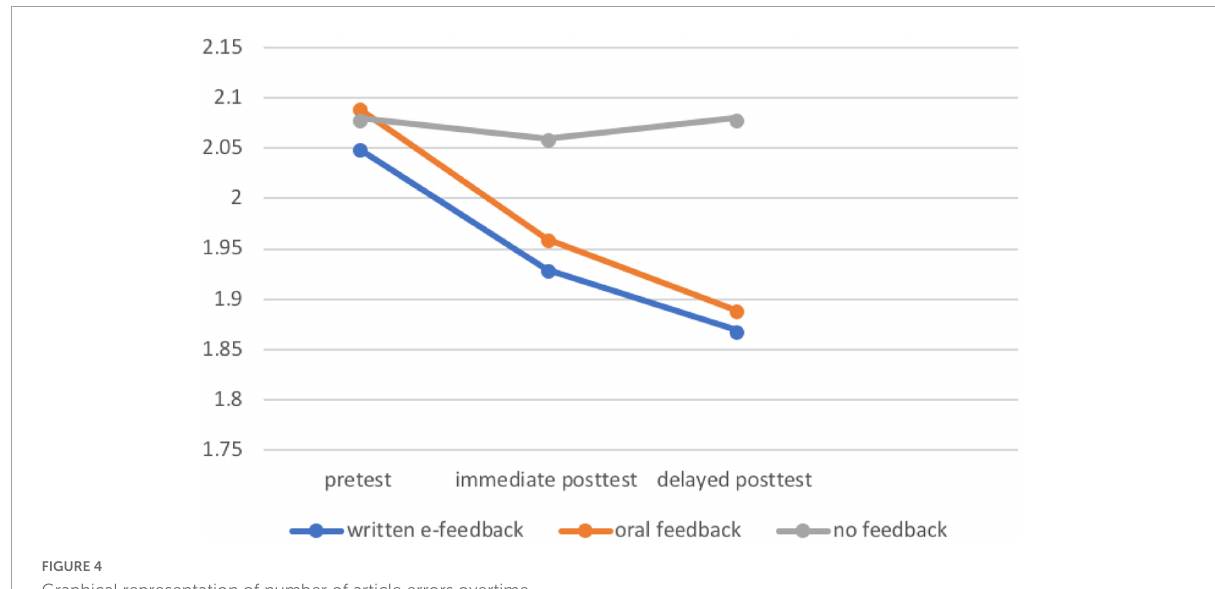
FIGURE4 Graphical representation of number of article errors